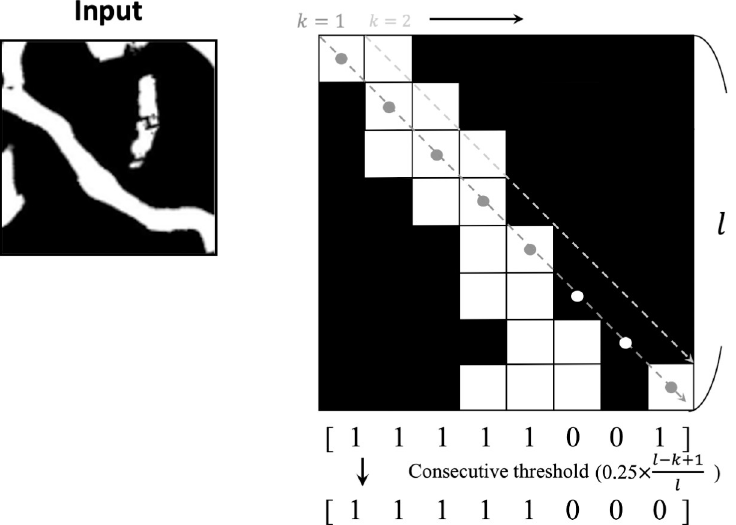
Fig 10. An example of the inputted matrix of 256 × 256 pix (left inset) and the explanatory figure of the estimation of the feeding trails’ direction (right inset). Right inset shows an example of calculating likelihood of 135˚. The white pixels show the area extracted as the feeding trails; element 1, and the black pixels show the background; element 0. The gray and white dots show the coordinates of elements 1 in the matrix M 1 . The row vectors v 1 and c 1 are shown in the lower inset; v 1 contains the sum of each column of M 1 × O 1 and was converted into c 1 , of which the non-consecutive element 1 within the threshold of 0.25( l − 1)/ l was replaced with